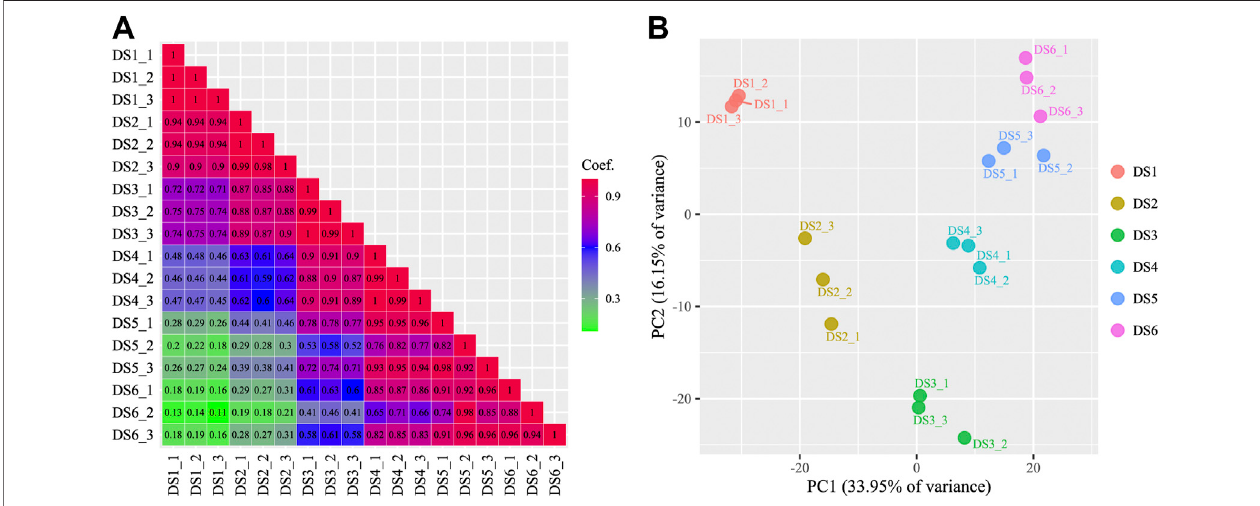
FIGURE 2 | A matrix showing the correlations among samples (A) and a scatter plot of samples based on principal component analysis (B) .